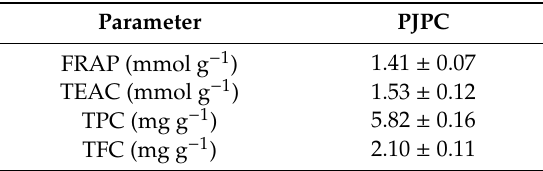
Table 5. Antioxidant activity expressed as the ferric-reducing antioxidant power (FRAP), Trolox equivalent antioxidant capacity (TEAC), total phenolic compounds (TPCs), and total flavonoid compounds